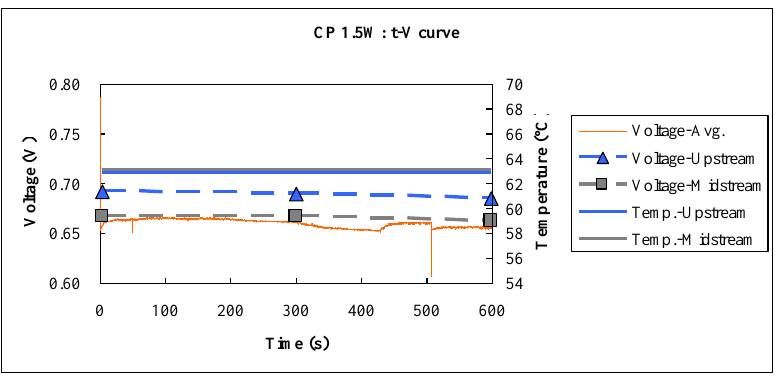
Figure 15. Voltage and temperature difference at constant power 1.5 W. CP 1.5W: t-V curve